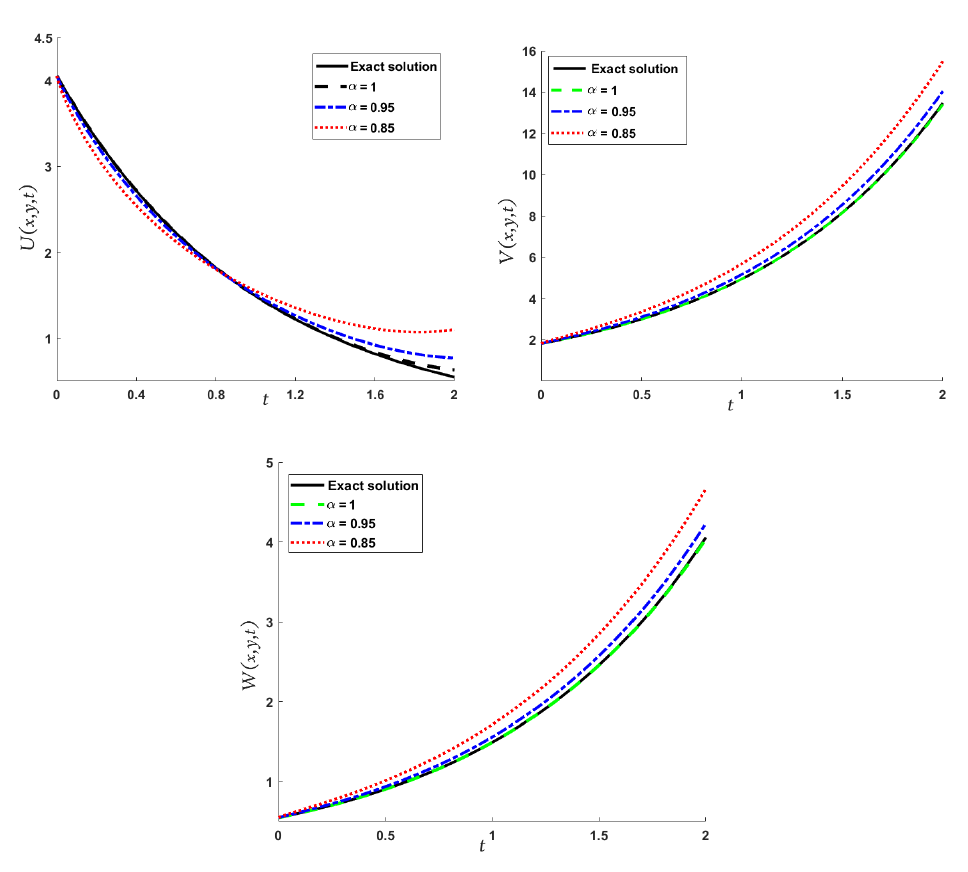
Figure 9. Two-dimensional plots of the approximate and exact solutions of U ( x , y , t ) , V ( x , y , t ) , W ( x , y , t ) (Example 3) using the LADM, when y = 0.4 and x =